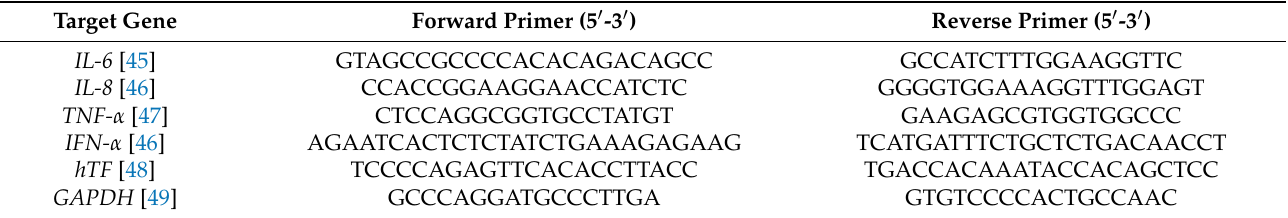
Table 1. SYBR Green Real Time PCR primer